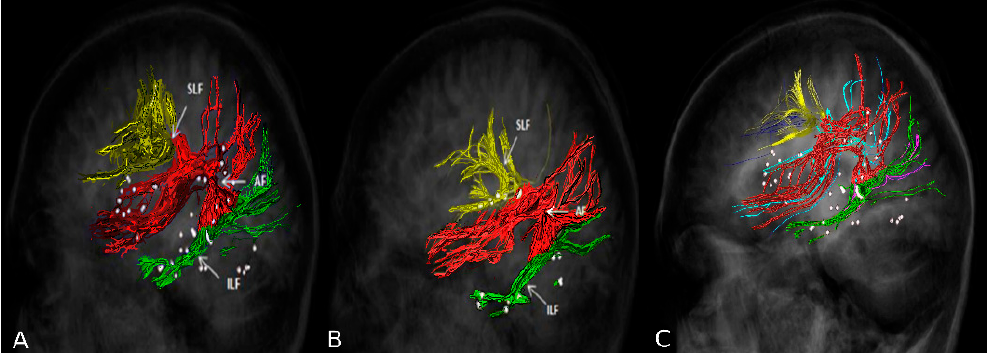
Figure 3. nTMS-based DTI-FT reconstructions of the language subcortical network in Romanian ( A ) and Italian ( B ) identifies the arcuate fascicle (AF, red), the superior longitudinal fascicle (SLF, yellow) and the inferior longitudinal fascicle (ILF, green) for both languages. In ( C ) the overlap of subcortical tracts is depicted. Italian color code—AF: red; SLF: yellow, ILF: green; Romanian color code—AF: light blue, SLF: blue, ILF violet.